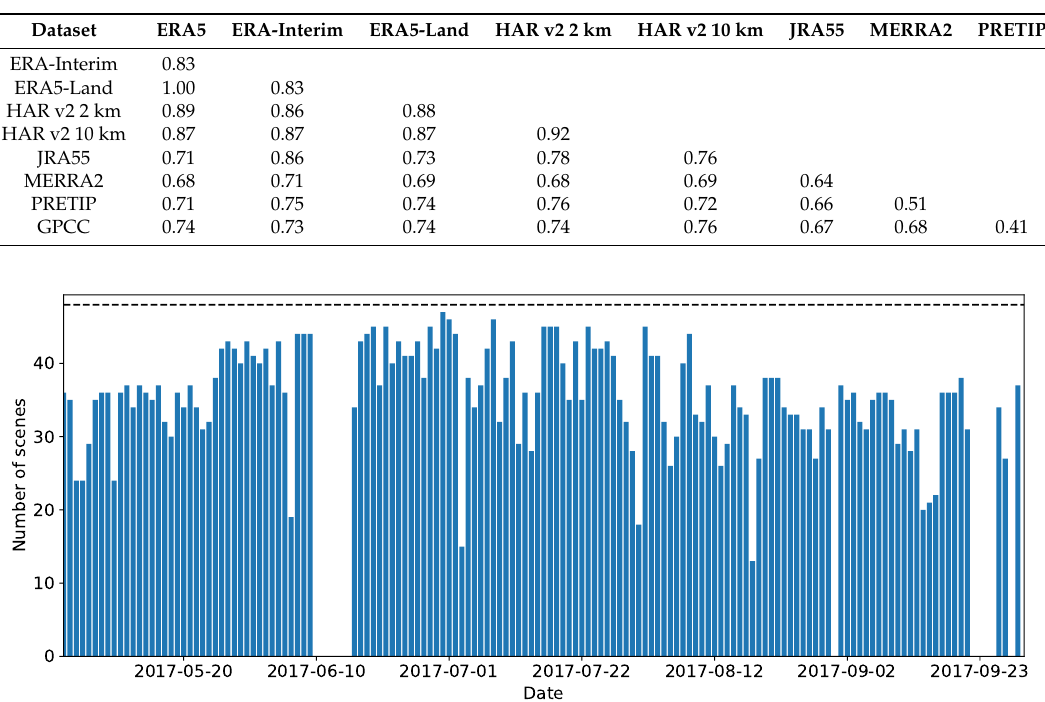
Table A2. Correlation coefficient R for all datasets in mm/month . All correlations are statistically significant at the 99% confidence interval.